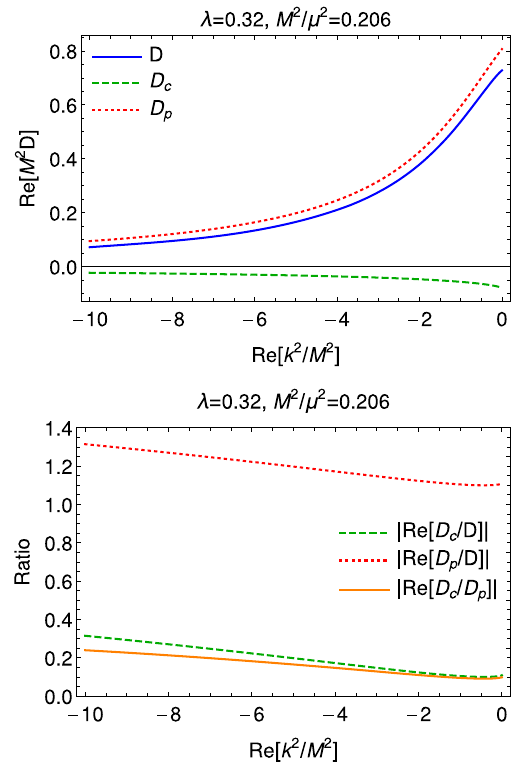
Fig. 18 The comparison of the pole and cut parts with the original gluon propagator in the Euclidean region D ( k 2 ) = D p ( k 2 ) + D c ( k 2 ) for k 2 < 0: (top) the pole part D p ( k 2 ) (red dotted line) and the cut part ( k 2 ) (green broken line) in the gluon propagator D ( k 2 ) (blue solid D c line), (bottom) the absolute values of the real part of the ratio of the pole and cut parts to the total gluon propagator, | Re [ D p ( t )/ D ( t ) ]| (red dot- tedline), | Re [ D c ( t )/ D ( t ) ]| (greenbrokenline),and | Re [ D c ( t )/ D p ( t ) ]| (orange solid line), at the physical point of the parameters λ := Ng 2 /( 4 π) 2 = 0 . 32, M 2 /μ 2 = 0 . 206